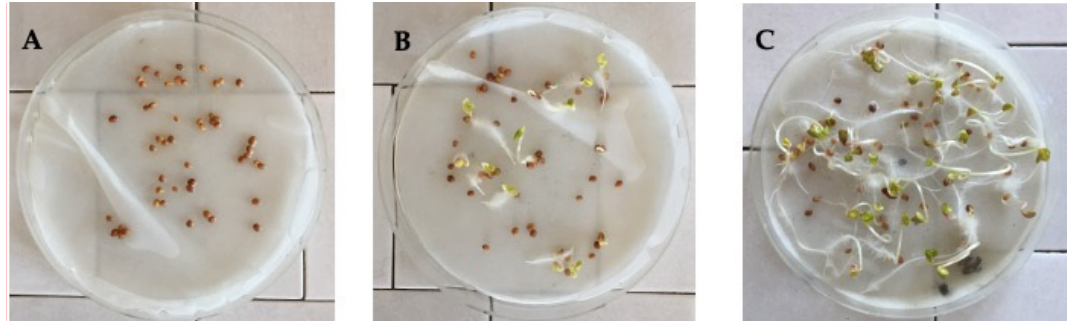
Figure 5. Inhibition of Raphanus sativus seed germination by Lavandin flowers and stems aromatic waters. ( A ) Raphanus sativus seed + flowers aromatic water; ( B ) Raphanus sativus seed + stems aromatic water; ( C ) Raphanus sativus seed + H 2 O = control.